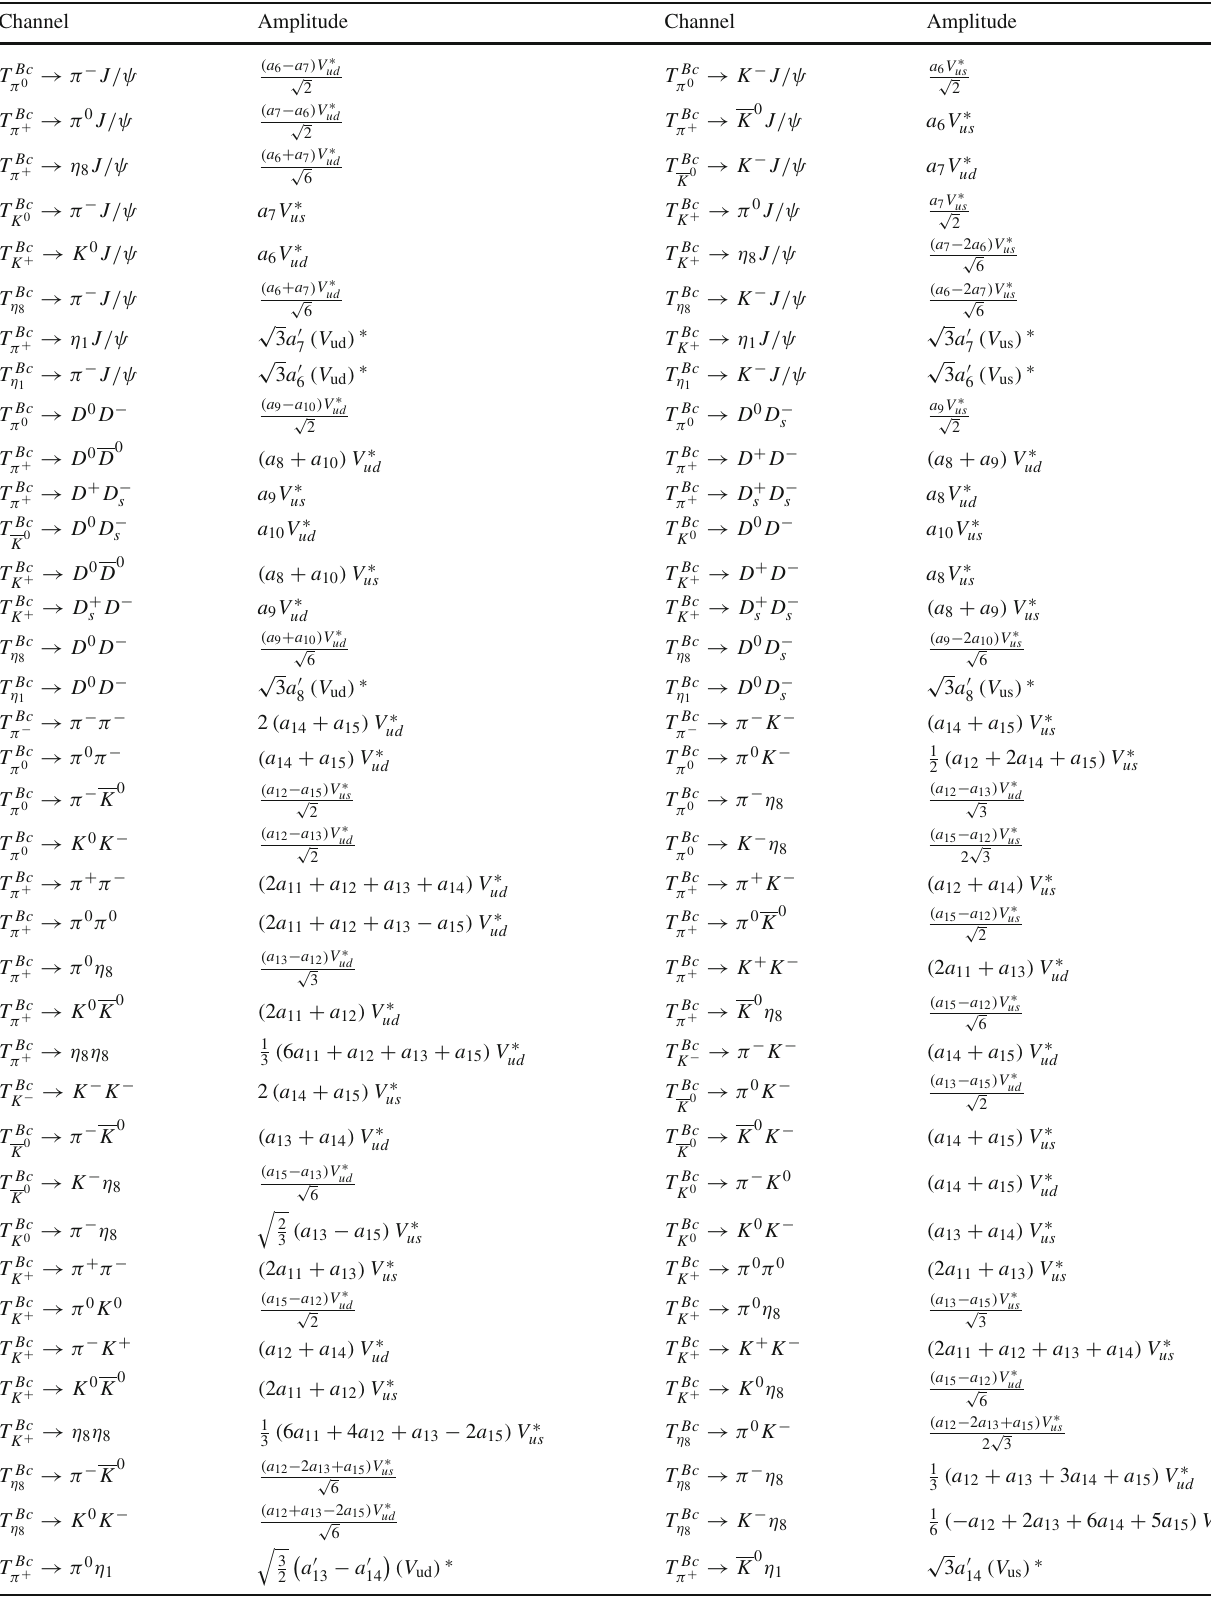
Table 4 Tetraquark T b ¯ c 8 / T b ¯ c 1 decays into J /ψ plus light meson or charmed meson plus anti-charmed meson or two light mesons Channel Amplitude Channel